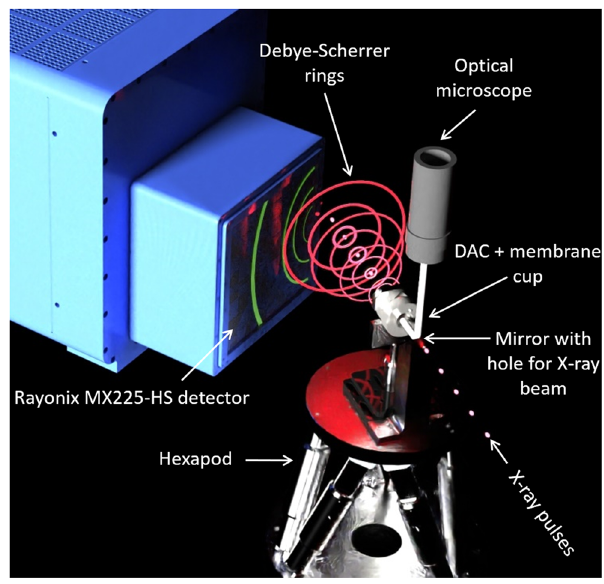
Fig. 2 Schematic showing the experimental setup at the XSS station at PAL-XFEL. X-ray diffraction data were collected on a Rayonix MX225-HS fl at panel detector that was horizontally offset to avoid the direct X-ray beam and positioned at an angle of ~45° with respect to the incoming beam. The sample was viewed using a camera attached to an optical microscope that was positioned above the sample stage, where optical access to the sample was provided by a mirror with a small hole to allow for transmission of the X-ray beam. The sample holder was placed on a Hexapod stage which was used to position the sample in the